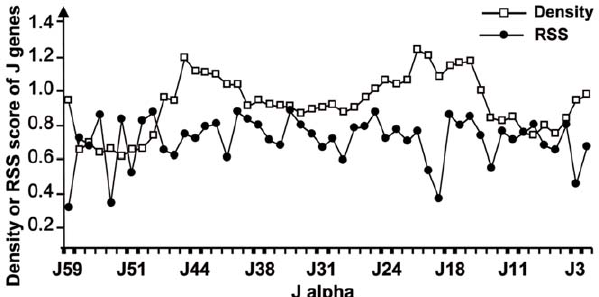
Figure 9. Density and RSS scores of the J genes. Values for the density (open squares) and RSS scores (dark circles) were calculated, as described in methods, for each J gene from the four previous and next genes. X axis represents the J genes, the Y axis the density or the RSS score for all J genes.